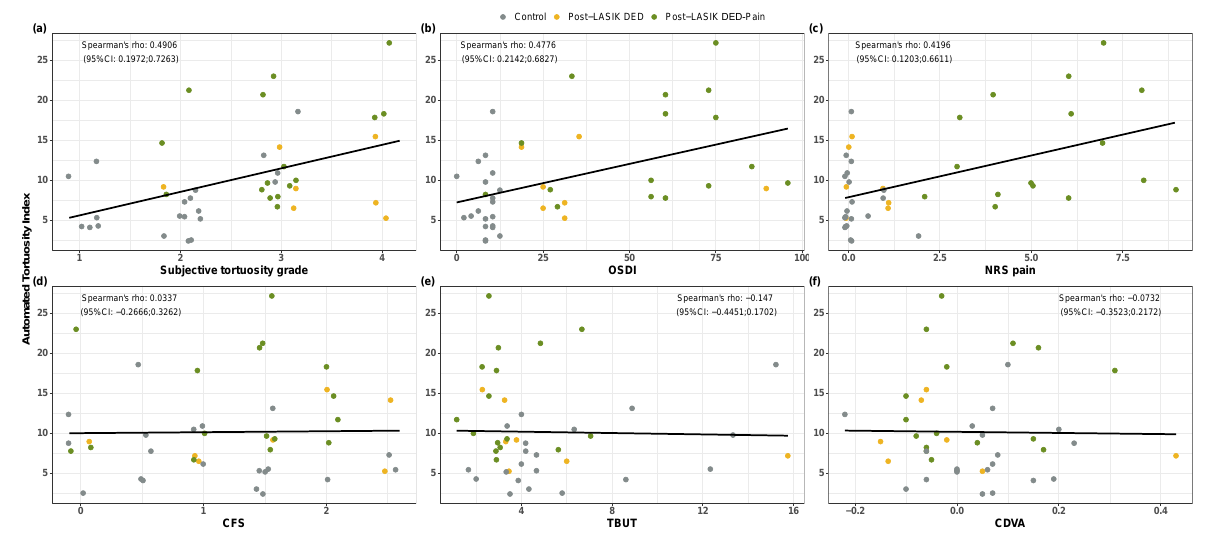
Figure 4. Correlations between the automated tortuosity index and ocular parameters. Spearman’s rank correlation coefficients and 95% CI are shown on the scatterplots for the automated tortuosity index against ( a ) subjective tortuosity index, ( b ) OSDI score, ( c ) NRS pain score, ( d ) CFS, ( e ) TBUT and ( f ) CDVA. Values of the ordinal variables are jittered to prevent